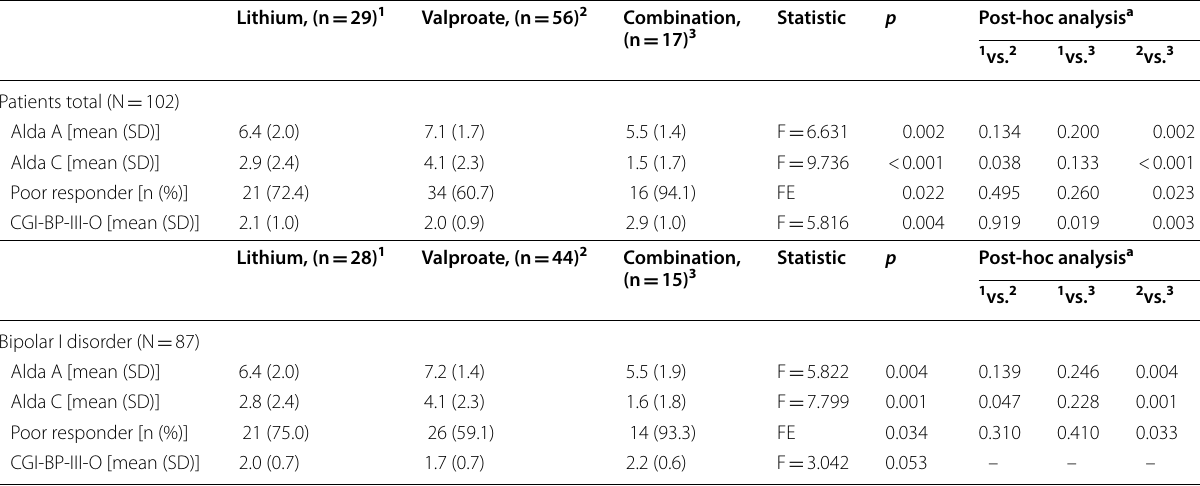
Table 2 Comparison of treatment responses between medication